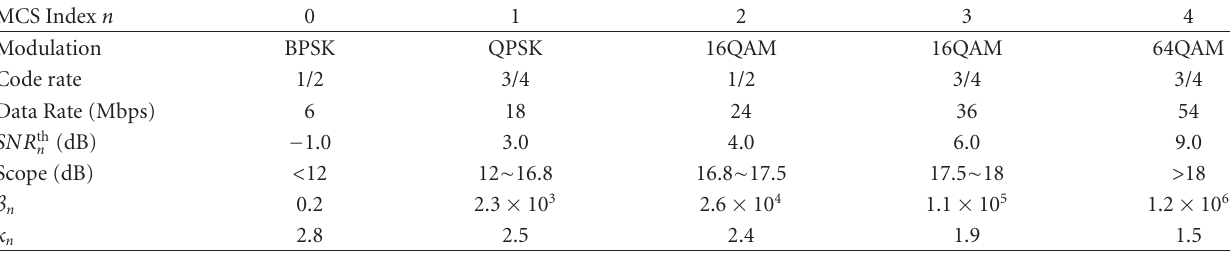
Table 2: Modulation and coding scheme